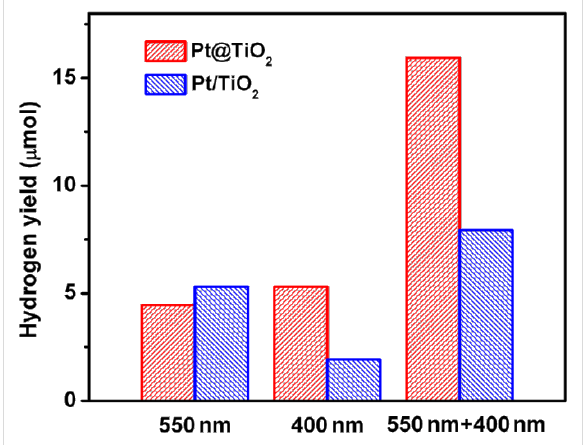
Figure 4: The H 2 yield from Pt@TiO 2 and Pt/TiO 2 for water splitting under irridiation with the given for 2 h while using TEOA as the sacrifi- cial reagent.